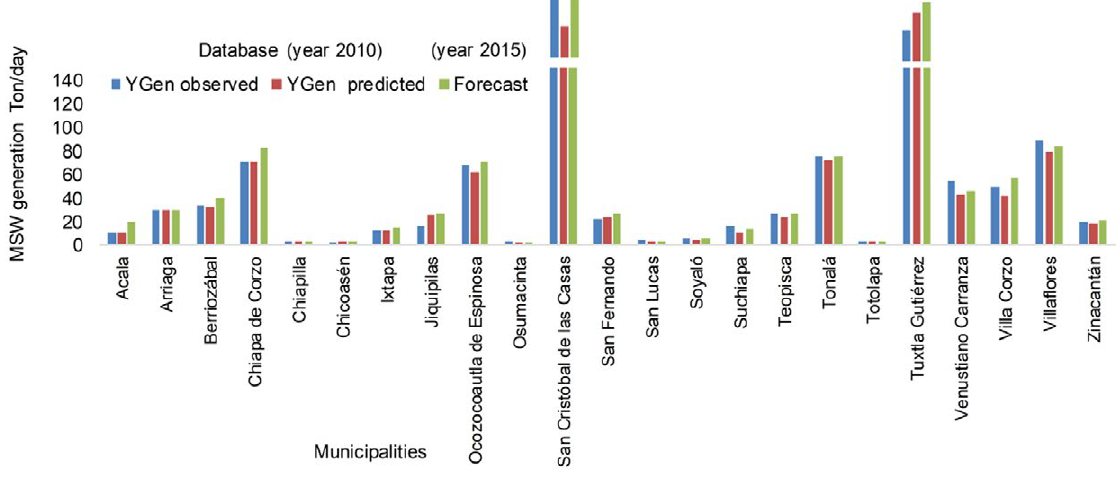
Fig. 5: Forecast of MSW generation rates in the municipalities of the study area